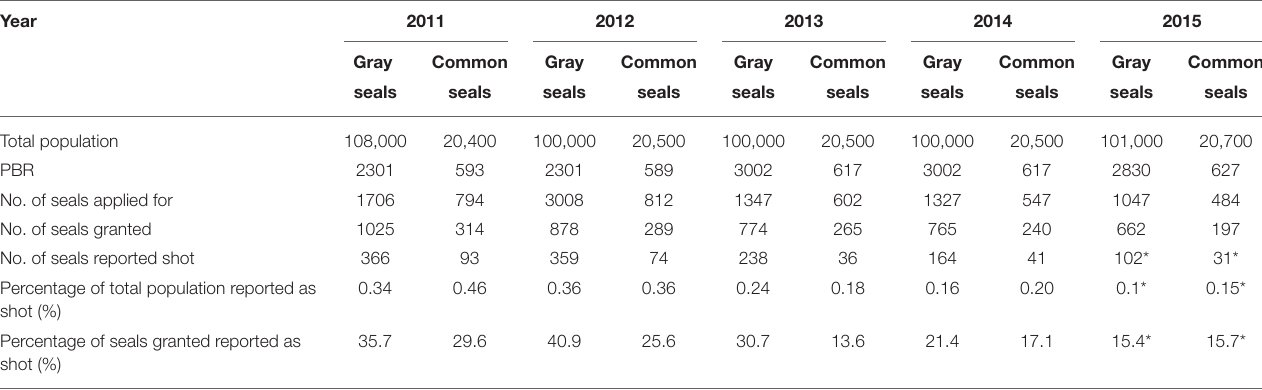
TABLE 1 | Gray seal and common seal total populations, Potential Biological Removal (PBR), numbers of seals applied for, granted and reported as shot, the percentage of the total population reported as shot and the percentage of the granted seals reported as shot in Scotland 2011–2015 ( Marine Scotland,